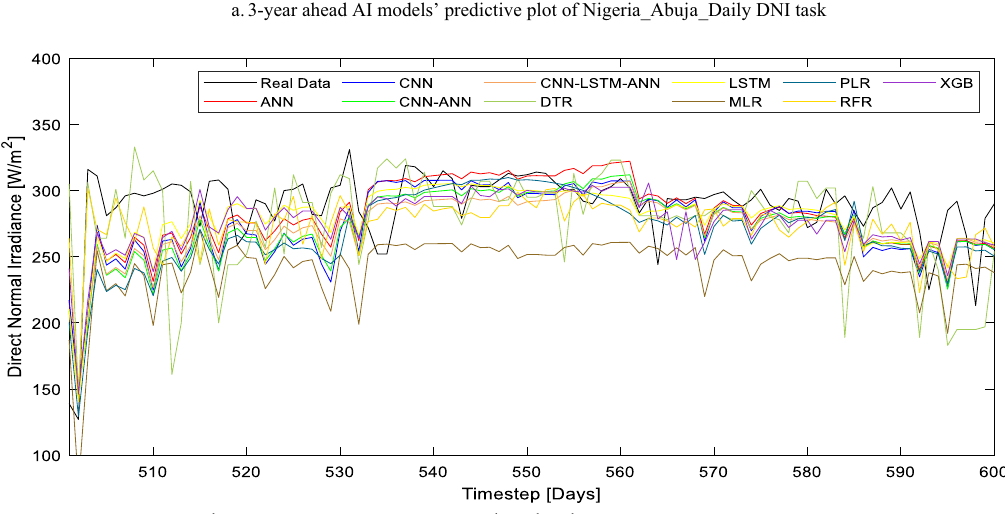
Figure 8. ( a ) 3-year ahead AI models’ predictive plot of Nigeria_Abuja_Daily DNI task. ( b ) Nigeria_Abuja_ Daily_DNI task day-ahead AI models’ predictive plot for